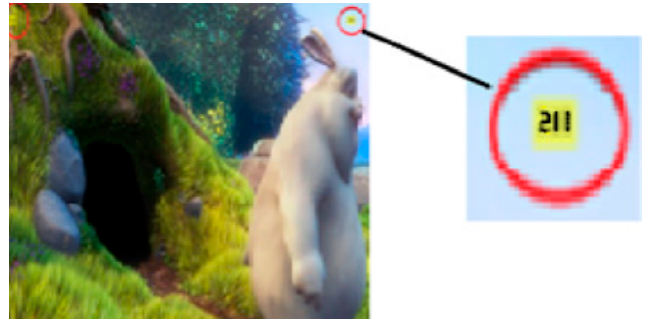
Figure 7. A typical transmitted image with its sequence number indicated on top corners.